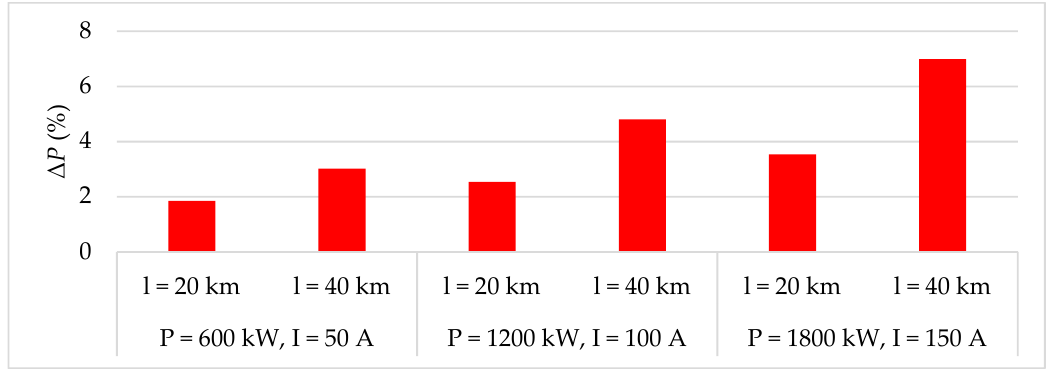
Figure 25. The comparison of the APLs for three types of active powers for conductor ACSR 70/11. Energies 2019 , 12 , x FOR PEER REVIEW